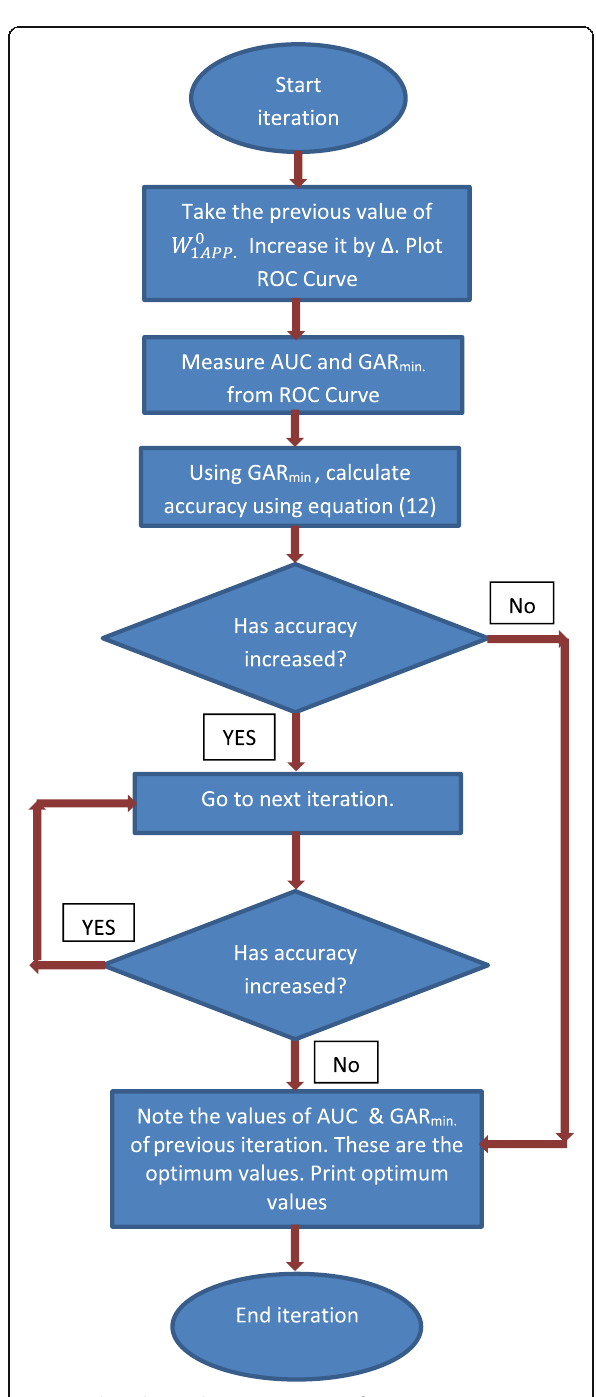
Fig. 10 Flow chart indicating sequence of iteration